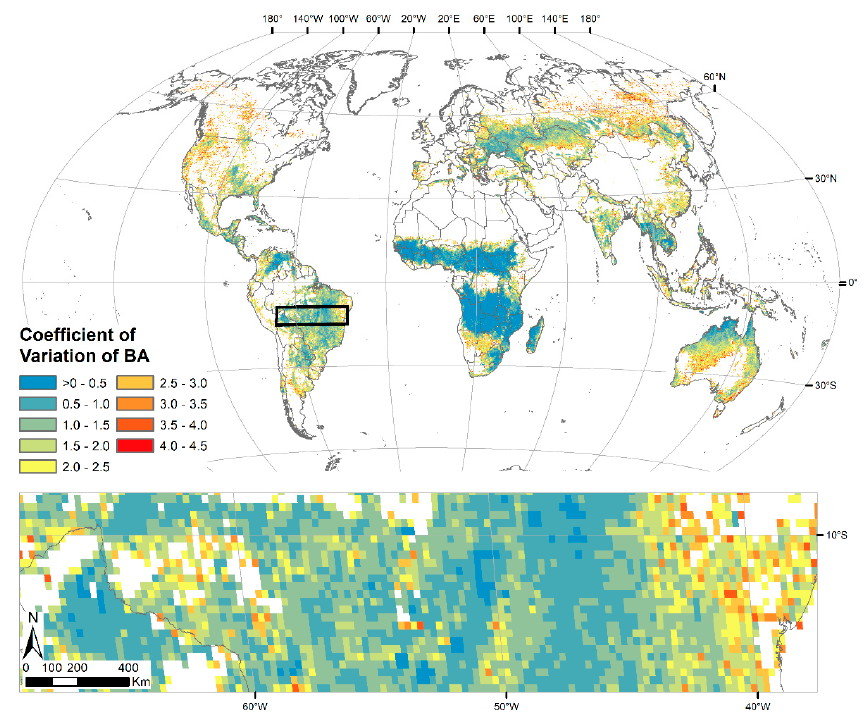
Figure A3. Spatial distribution of the coefficient of variation of the burned area (see main text for definition and further details). The bottom panel shows a zoomed region in central South America, as delineated in the global map.